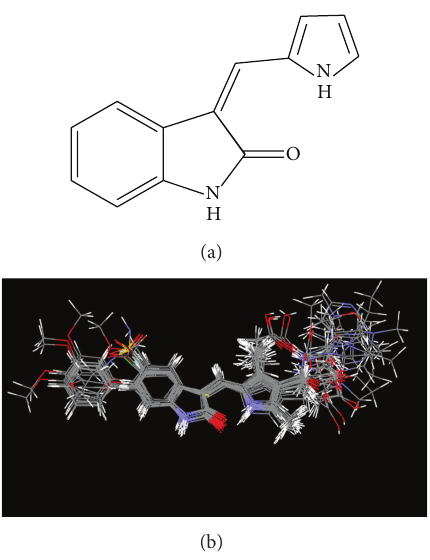
Figure 2: Superposition of compounds of using alignment B, based on common structure. (a) Common fragment for superposition; (b) superposition of compounds in training and test